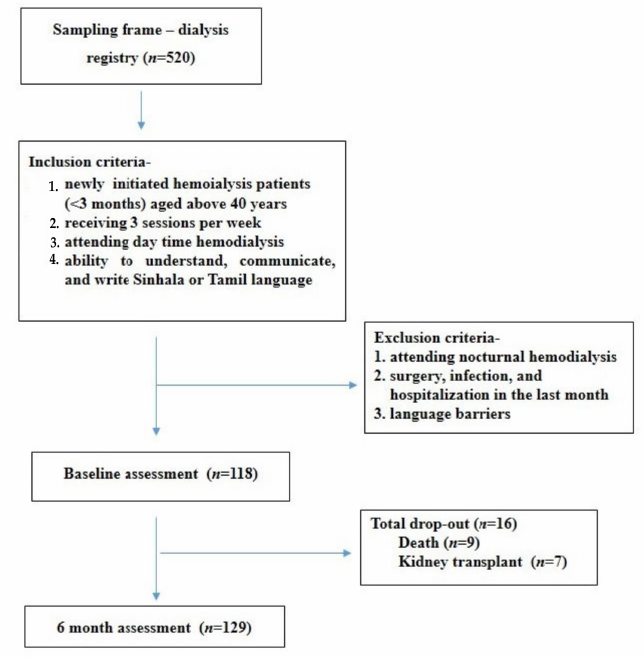
Figure 1. Patient recruitment procedure for the